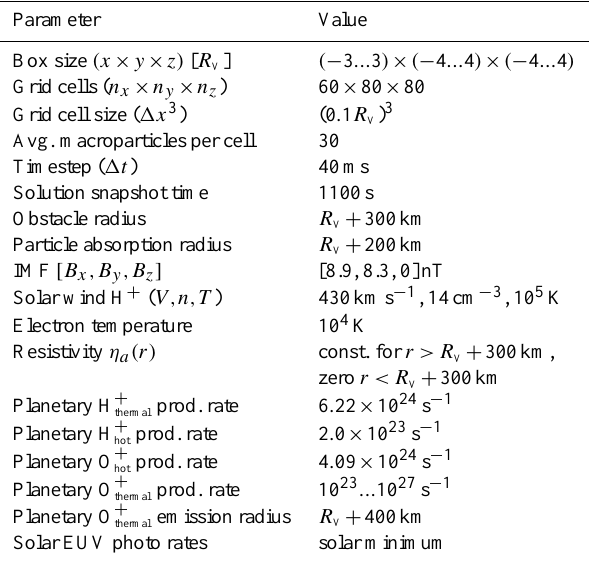
Table 1. Details of the HYB-Venus simulation runs and the used upstream conditions for the Venus Express orbit on 20 November 2006.